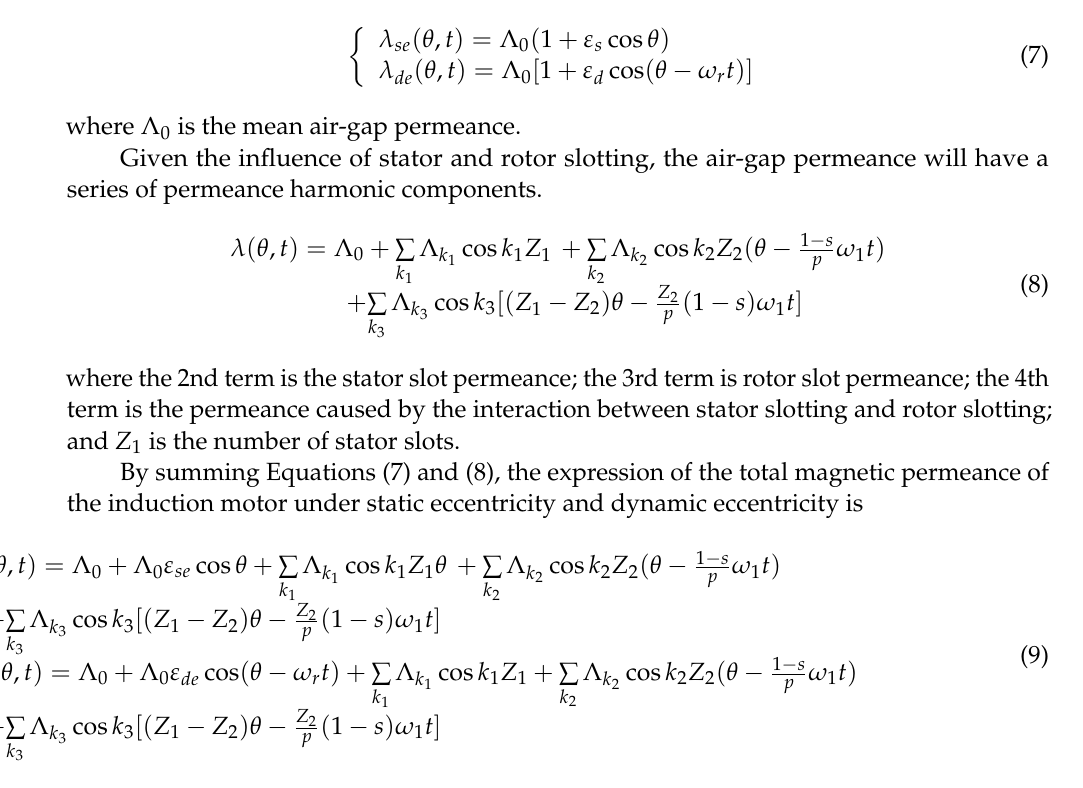
If only the influence of eccentricity is factored in, the expression of air-gap permeance is